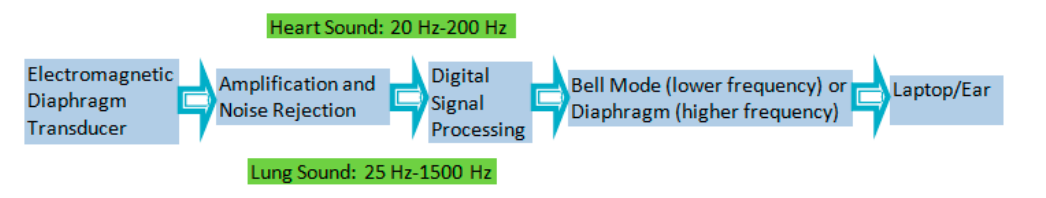
Figure 1. Block diagram of the DS32a digital stethoscope.